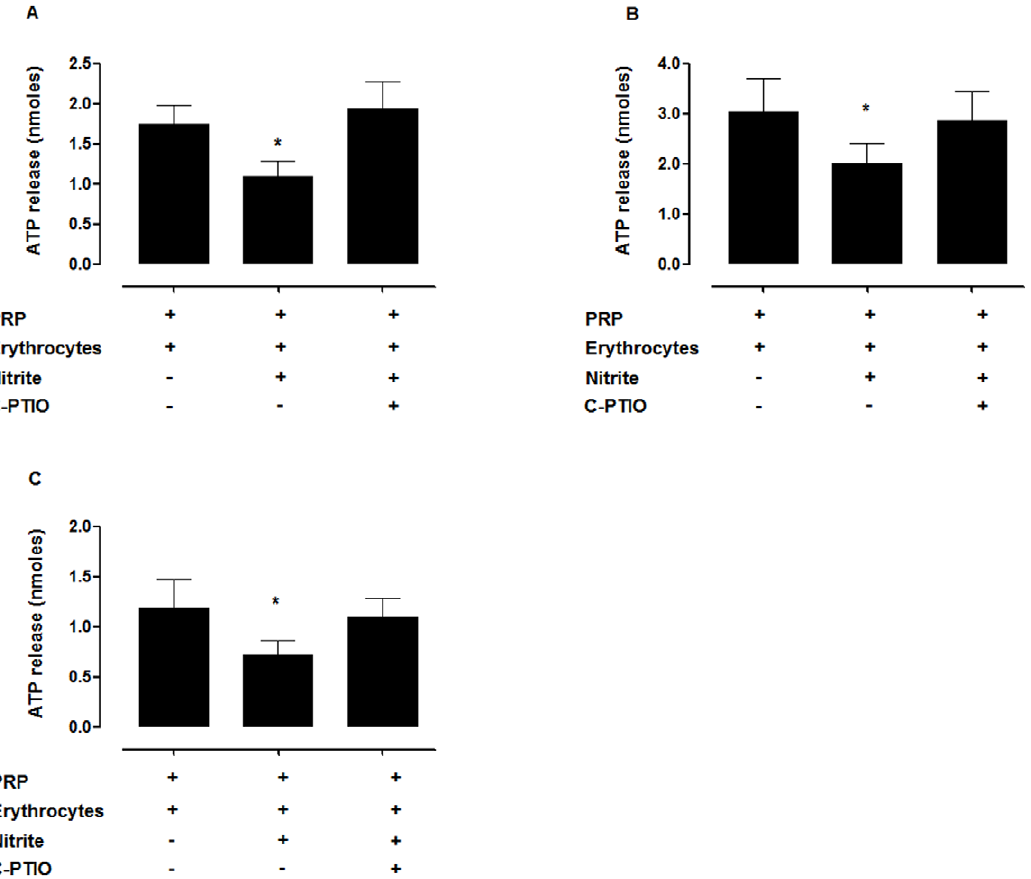
Figure 3. Nitrite + erythrocytes inhibited ATP release from platelets induced by ADP (A), collagen (B), and U46619 (C). PRP + erythrocytes (20% hematocrit) were incubated with 0.1 m M nitrite in the presence and absence of 200 m M C-PTIO for 5 min. The ATP release was induced by 20 m M ADP, 2.5 m g/mL collagen or 1 m M U46619. * P , 0.05 compared with PRP + erythrocytes and PRP + erythrocytes + nitrite + C-PTIO (ANOVA). All experiments were performed at 37 u C. Data are means 6 SEM (n=5).